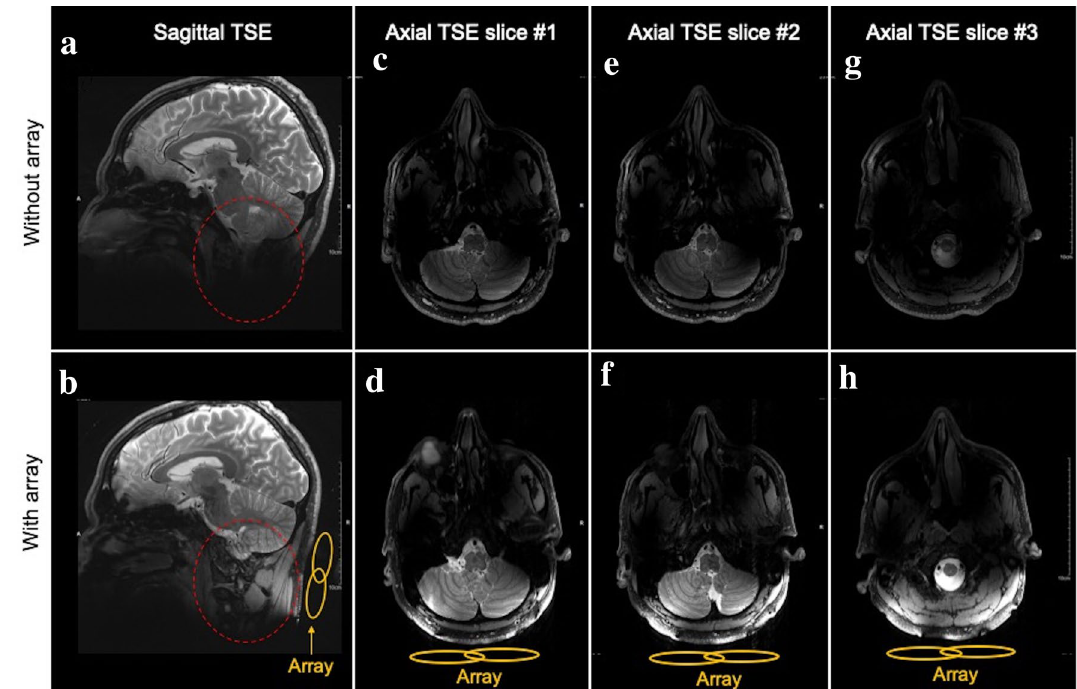
Figure 7. In vivo brain MRI at 7T. Sagittal T2-weighted TSE images obtained without ( a ) and with ( b ) the RF array show significant SNR and CNR improvement in the inferior regions in the presence of the array. In particular, the cerebellum, brainstem, and neck muscle are more clearly visible using the RF array. Axial T2-Weighted TSE slices obtained at various locations in the lower brain. Images obtained in slice #1 ( c , d ) show that placing the RF array results in significant improvement in B + 1 uniformity and SNR in the cerebellum and brainstem. Slice #2 ( e , f ) and slice #3 ( g , h ) obtained at the physical border and 2 cm extended outside of the border, respectively. These images show that using the RF array extends the anatomical coverage of the head coil visualizing vertebral artery and spinal cord, which are hardly visible without the